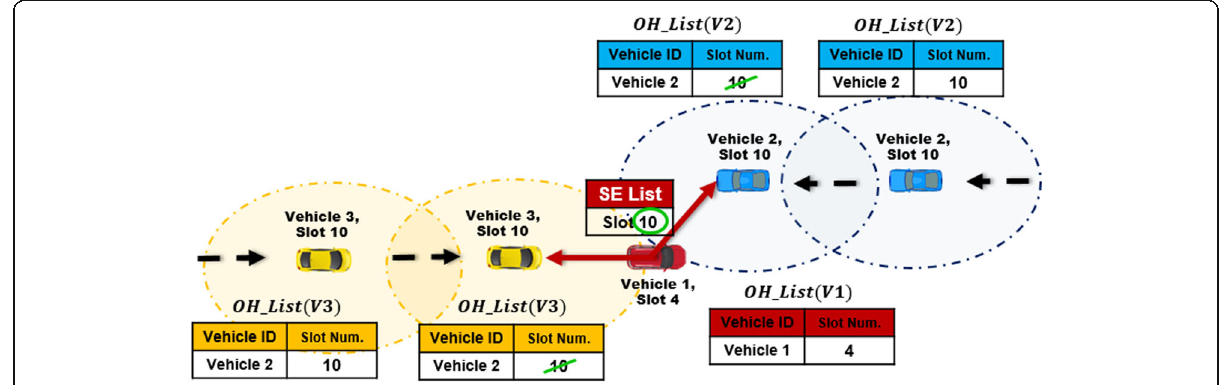
Fig. 9 Fast collision detection by utilizing the SE